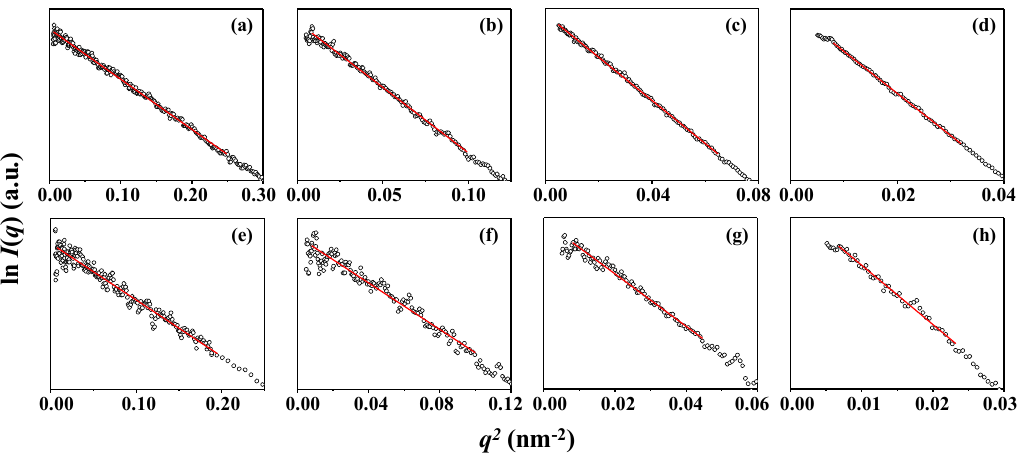
Figure 3. Guinier analysis results of the X-ray scattering data in Figure 2; CHX at 35.0 ° C ( Θ condition): ( a ) 17-Arm(2k)-PS; ( b ) 17-Arm(6k)-PS; ( c ) 17-Arm(10k)-PS; ( d ) 17-Arm(20k)-PS; THF at 25.0 ° C (good solvent): ( e ) 17-Arm(2k)-PS; ( f ) 17-Arm(6k)-PS; ( g ) 17-Arm(10k)-PS; ( h ) 17-Arm(20k)-PS. Table 2. Structural parameters of 17-armed star polystyrenes obtained by X-ray scattering and dynamic light scattering (DLS) analyses.